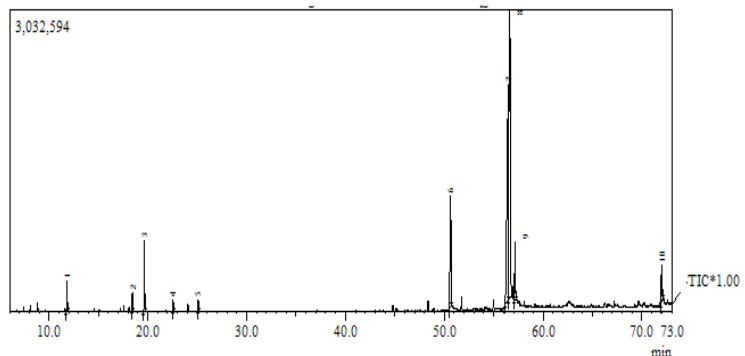
Figure 1. Chromatogram: GC-MS chromatogram of Foeniculum vulgare essential oils.